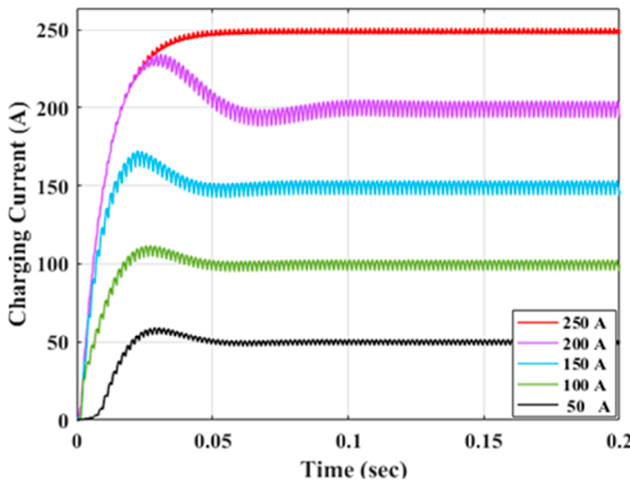
Figure 15. Output current response at (V battery = 250 V, θ on = 0°).